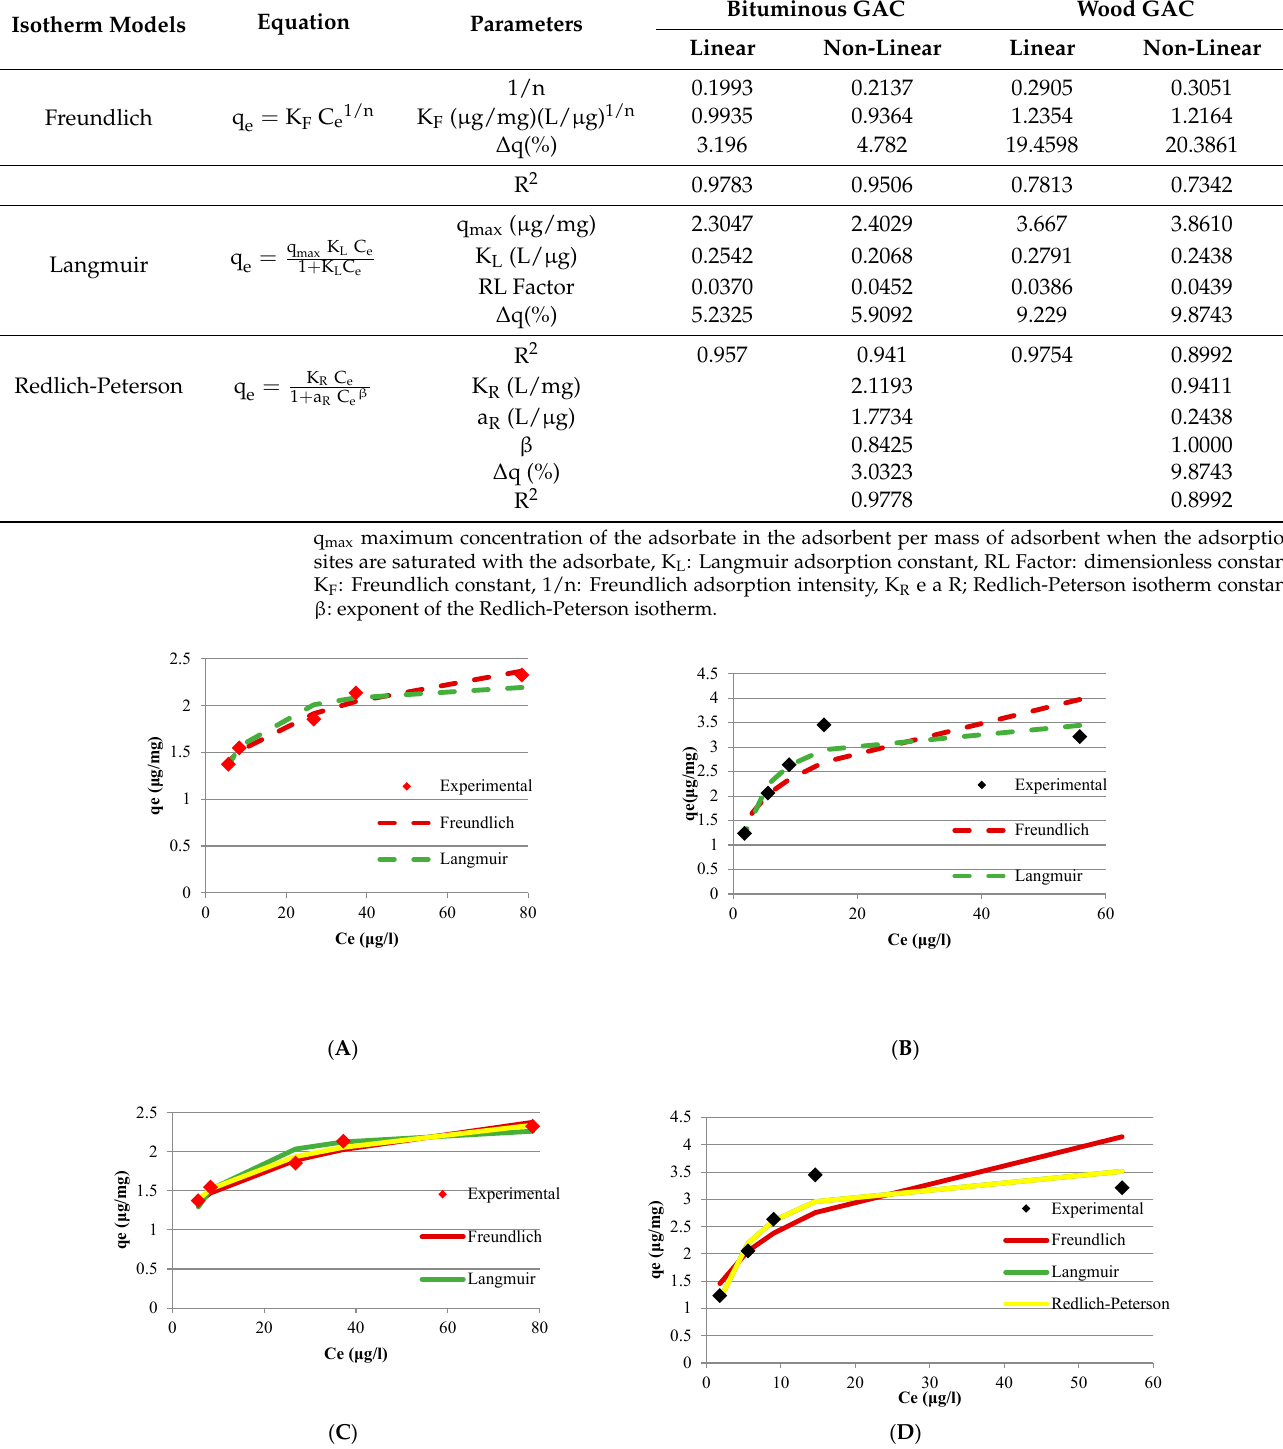
Figure 8. ( A ) Bituminous GAC, experimental and calculated data, parameters obtained by linear regression; ( B ) Wood GAC, experimental and calculated data, parameters obtained by linear regression; ( C ) Bituminous GAC, experimental and calculated data, parameters obtained by non-linear regression; ( D ) Wood GAC, experimental and calculated data, parameters obtained by non-linear regression.